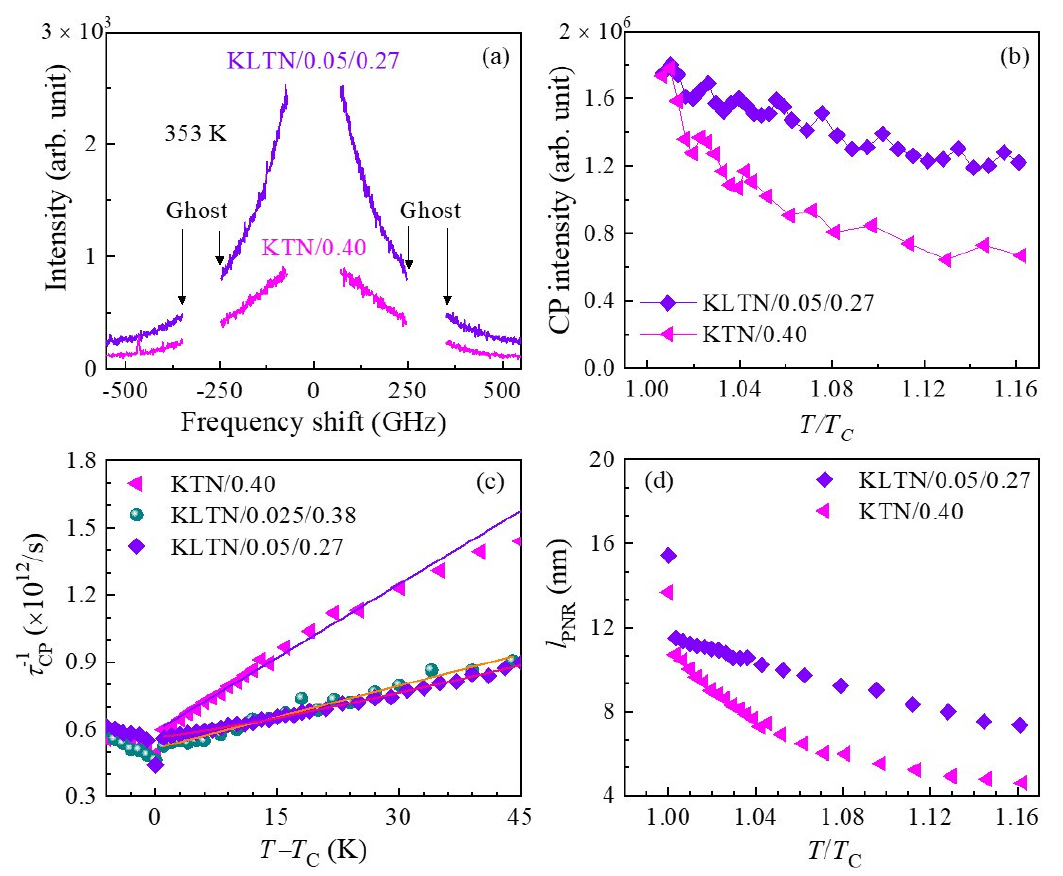
Figure 6. ( a ) The CP spectra of KTN/0.40 and the KLTN/0.05/0.27 single crystals measured with the FSR = 300 GHz at 353 K. ( b ) The CP intensity of KTN/0.40 (solid diamonds) and KLTN/0.05/0.27 (solid triangles) single crystals as a function of T/T C . ( c ) The inverse of the relaxation time estimated from the width of the CP of non-doped KTN, 2.5%Li-doped KTN, and 5%Li-doped KTN single crystals as a function of normalized temperature. The solid lines are the lines fit with Equation (12) ( d ) The size of a dynamic PNR of non-doped KTN and 5%Li-doped KTN crystals as a function of T / T C . The data were adapted from Refs. [27,58].